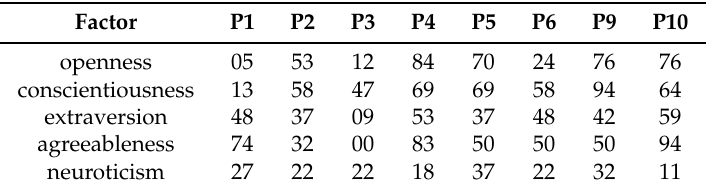
Table 2. Results of the Big Five Test for the analysed